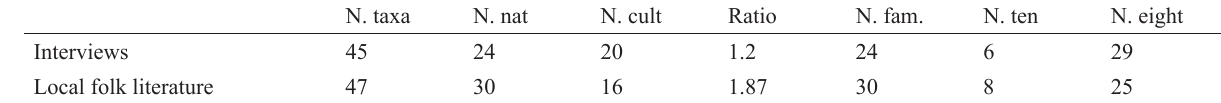
Table 1. Comparison between plant taxa reported in interviews and plant taxa cited in local folk literature. Abbreviations are: N. taxa, total number of taxa; N. nat, Number of native taxa; N. cult, number of cultivated taxa; Ratio, N. nat/N. cult; N. fam, total number of families; N. ten, number of families of the 10 most popular species; N. eight, number of species of the 8 most popular